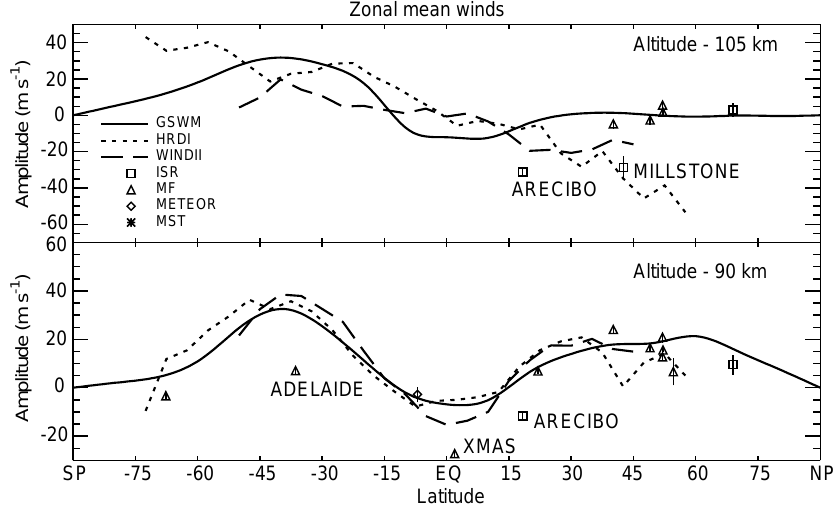
Fig. 5. A latitude cross section of zonal mean winds for an altitude of 105 km ( top ) and 90 km ( bottom ). The mean winds are shown from the GSWM ( solid ), HRDI ( short dash ), WINDII ( long dash ), and the ground-based radar facilities ( assorted